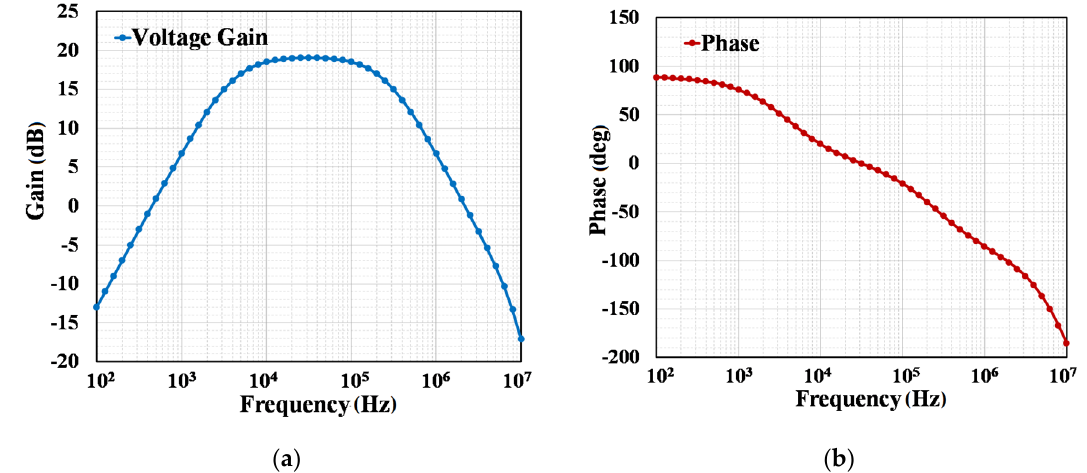
Figure 12. Simulation results of IF amplifier: ( a ) gain; ( b ) phase.